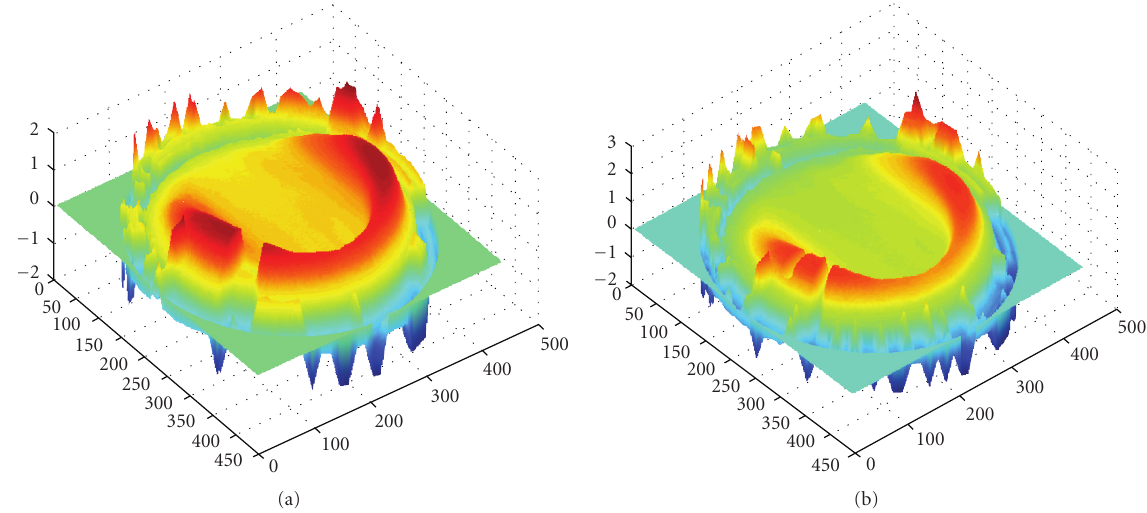
Figure 8: Phase unwrapped H channel obtained using a threshold value of 0.25 (a) and of 0.2